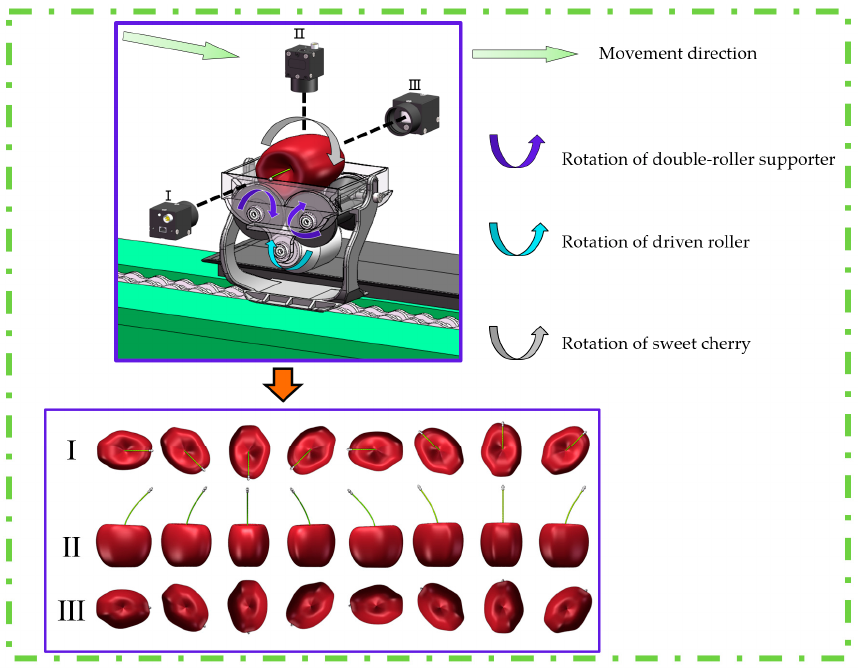
Figure 9. Operation principle for rotating: I—images captured by left camera; II—images captured by above camera; III—images captured by right camera.